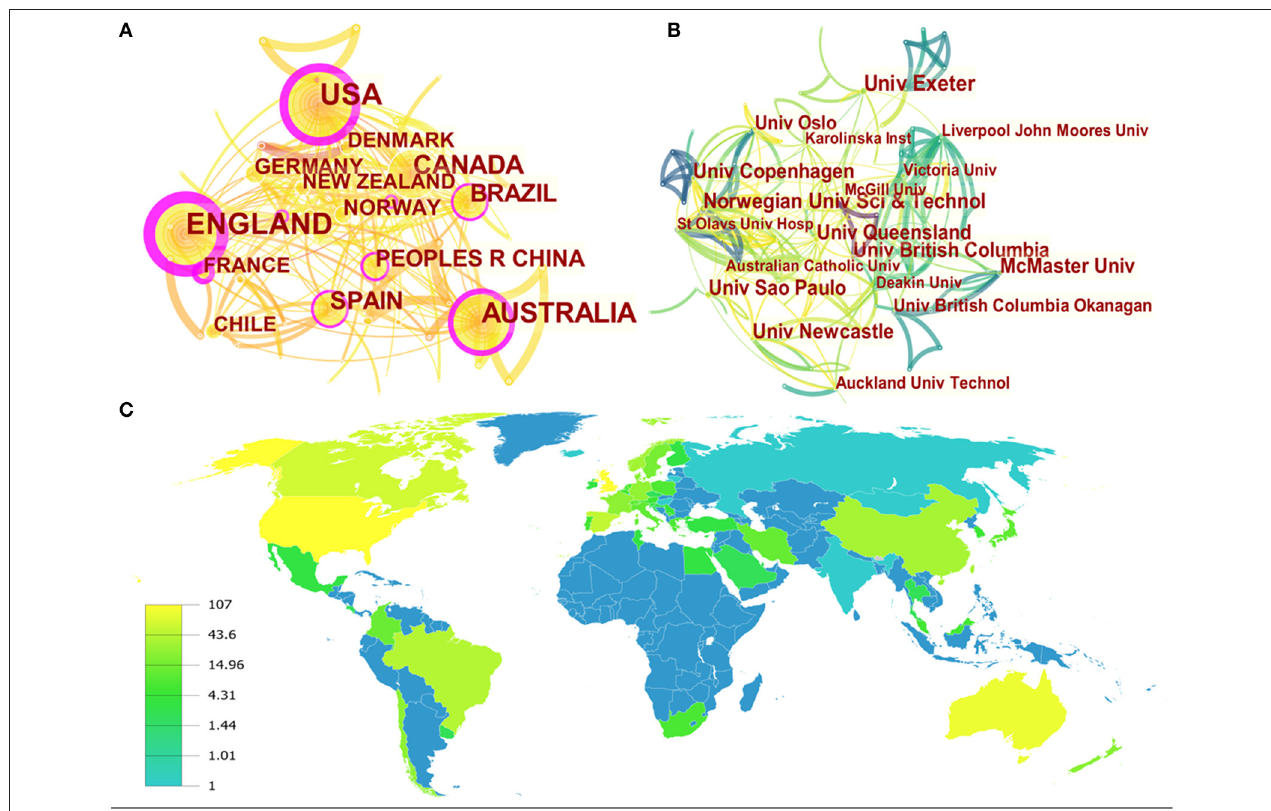
FIGURE 3 | The map of countries (A) , institutions (B) , and world distribution (C) of publications in the HIIT-HP field.